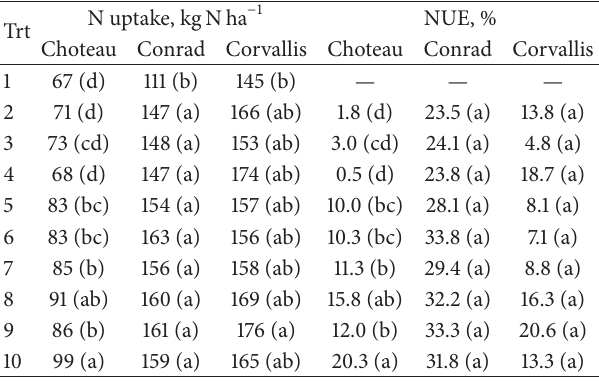
Table 7: Mean spring wheat N uptake and NUE, Choteau, Conrad, and Corvallis, 2012. Trt